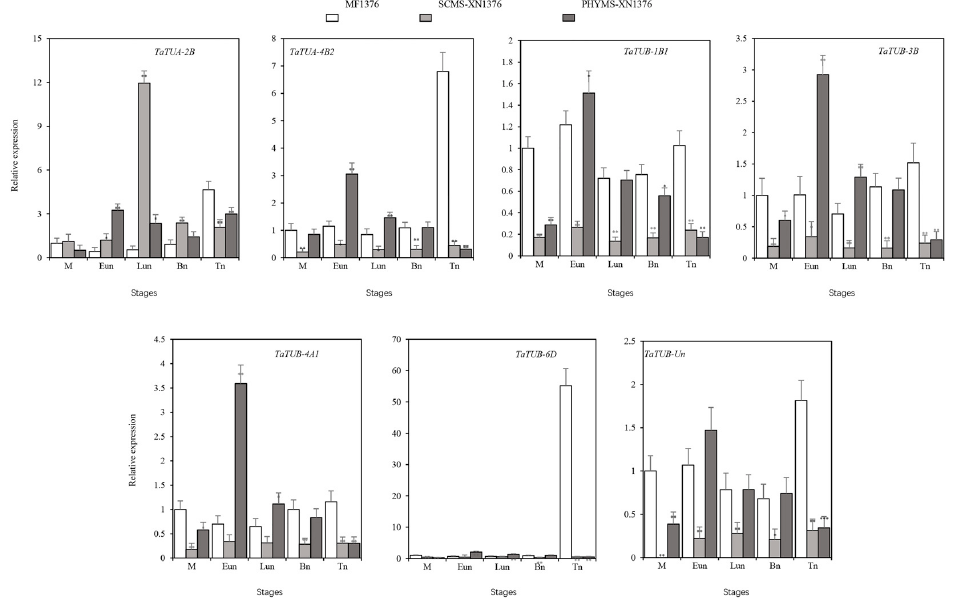
Figure 6. Expression patterns of TaTUA and TaTUB genes in anthers of MF-XN1376, SCMS-XN1376, and PHYMS-XN1376. MF-XN1376: Xinong 1376; SCMS-XN1376: S-type cytoplasmic male sterile line; PHYMS-XN1376: physiological male sterility; M: Meiosis stage; Eun: Early-uninucleate stage; Lun: Late-uninucleate stage; Bn: Binucleate stage; Tn: Trinucleate stage. An asterisk (*) indicates significance at p -values < 0.05, two asterisks (**) indicates significance at p -values < 0.01, three asterisks (***) indicates significance at p -values < 0.001.